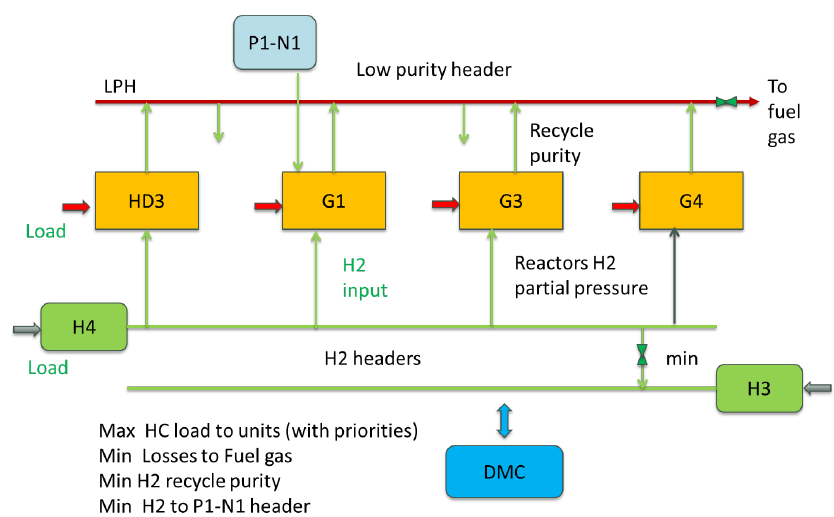
Figure 7. Diagram of the DMC controlling the operation of two hydrogen producers H3 and H4 and